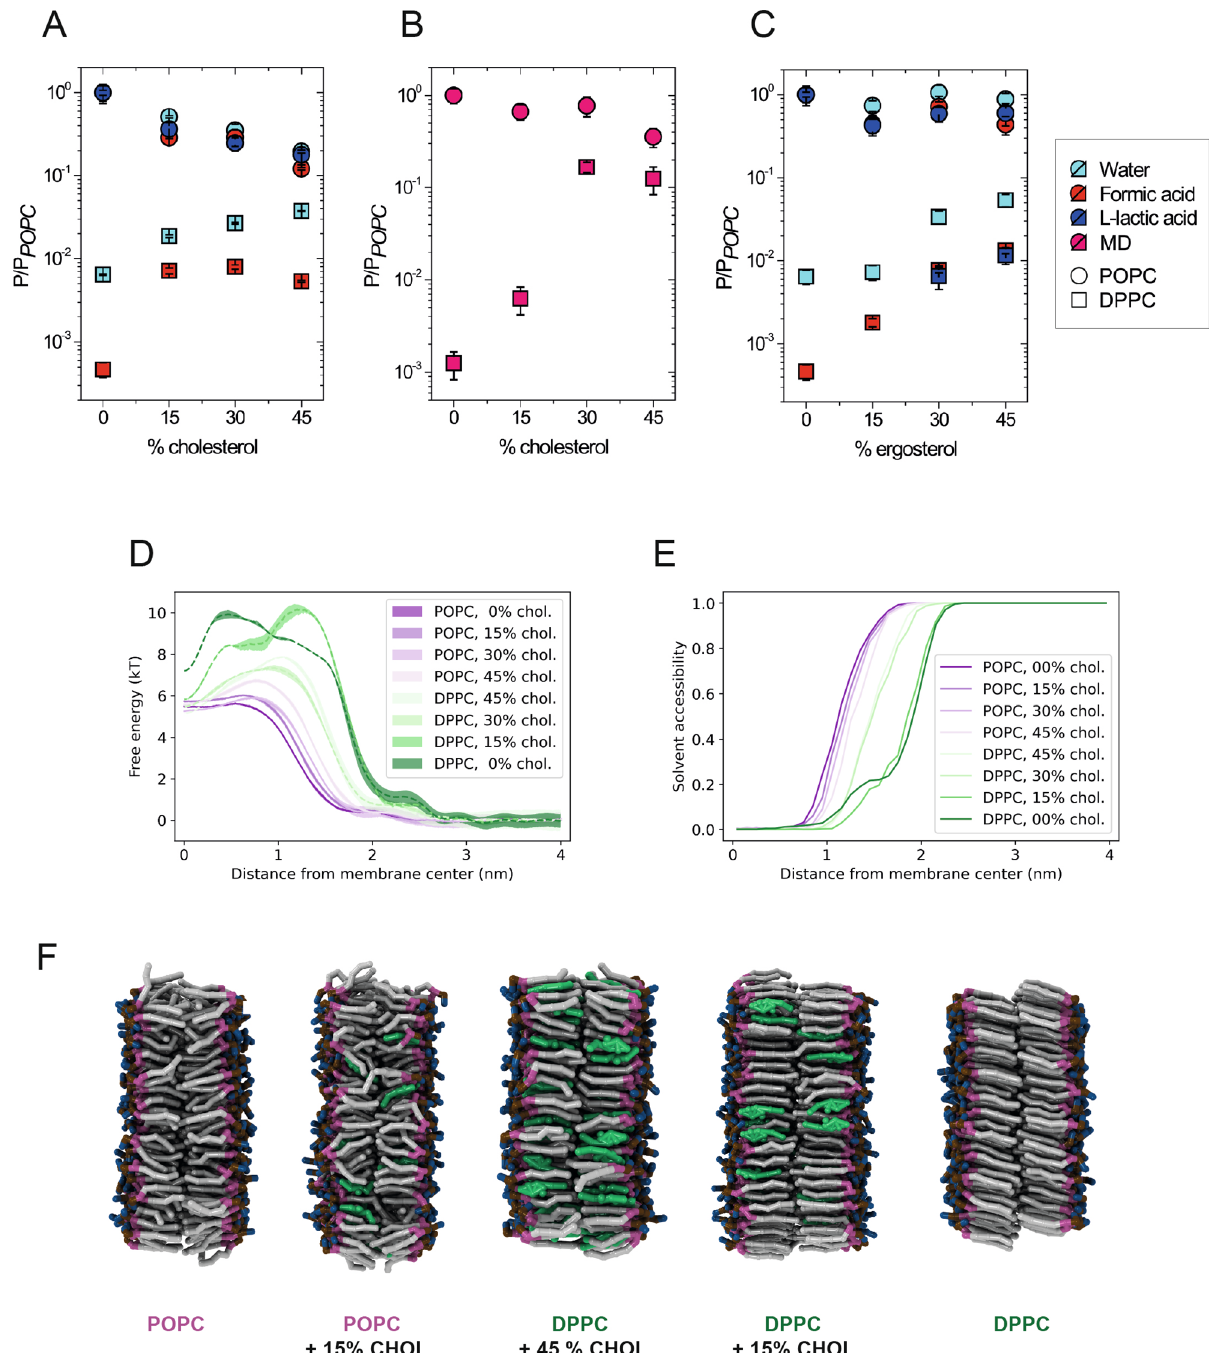
Fig. 4 Permeability of solutes as a function of sterol concentration. Permeability coef fi cients as a function of cholesterol ( A , B ) and ergosterol ( C ) concentration in POPC or DPPC vesicles from experiments ( A , C ) and simulations ( B ) at 20 °C. The permeability coef fi cients for each solute are normalized to the value in POPC vesicles, i.e., without sterol present; the permeability coef fi cient in POPC vesicles was 12.0 (±1.4) × 10 − 3 cm/s, 5.53 ± (0.74) × 10 − 3 cm/s, and 0.117 (±0.022) × 10 − 3 cm/s for water, formic acid, and lactic acid, respectively. Solute of the hydrophobic level I was used in the simulations. Data are presented as mean values + SEM. Data are presented as mean values ± SEM. Error estimates represented by error bars around the mean values are described in “ Methods ” ( “ Fit of the in vitro kinetics ” for experimental data, “ Inhomogeneous solubility-diffusion model ” , for MD simulations). The numerical values are presented in Supplementary Table 4. D , E Free energy ( D ) and solvent accessibility ( E ) pro fi les from simulated membranes in the L d phase and L β or L o phase at varying cholesterol concentrations. The largest changes in the pro fi les and in the permeability coef fi cients are between simulations in different phase states. F MD simulation snapshots of lipid membranes of various compositions at different phase states (lipid tails gray; glycerol moiety, purple; choline moiety, blue; phosphate moiety, ochre; cholesterol, green; water molecules are not